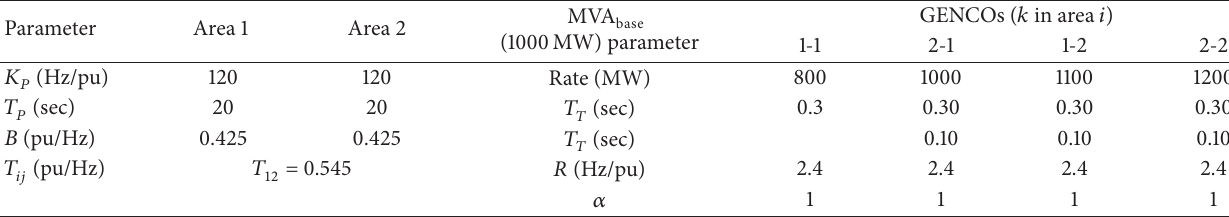
Table 3: Data of controller area and GENCOs.